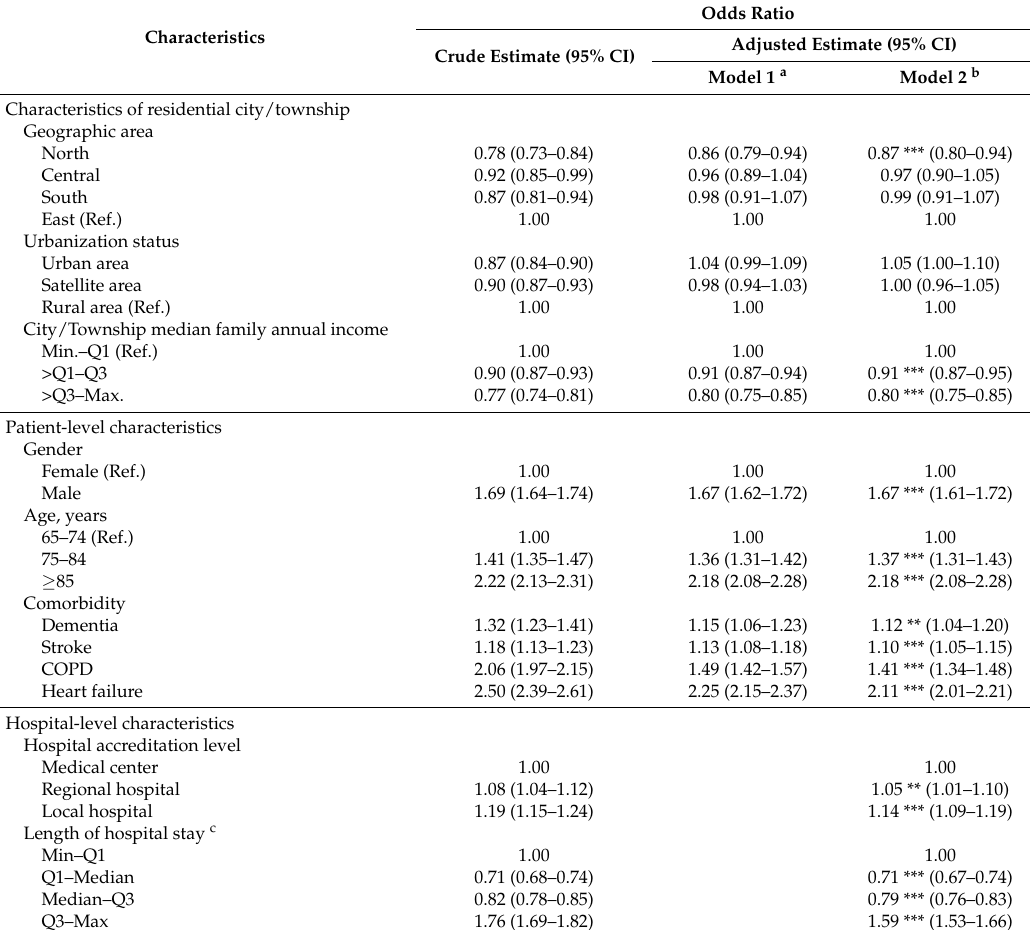
Table 2. Odds ratios of one-year mortality in relation to patient- and hospital-level characteristics and residential city/township